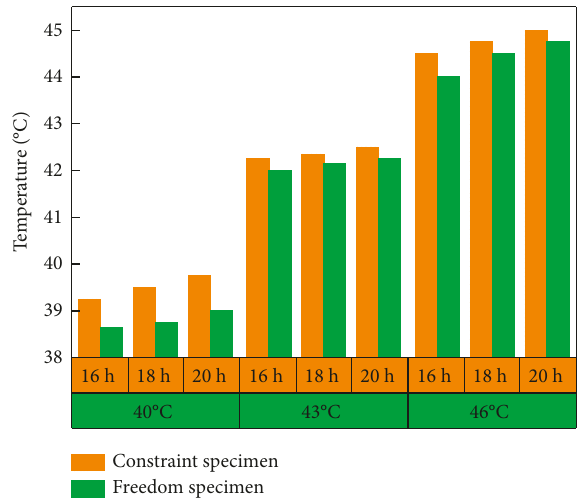
Figure 6: Temperature variations under different extreme high- temperature conditions.